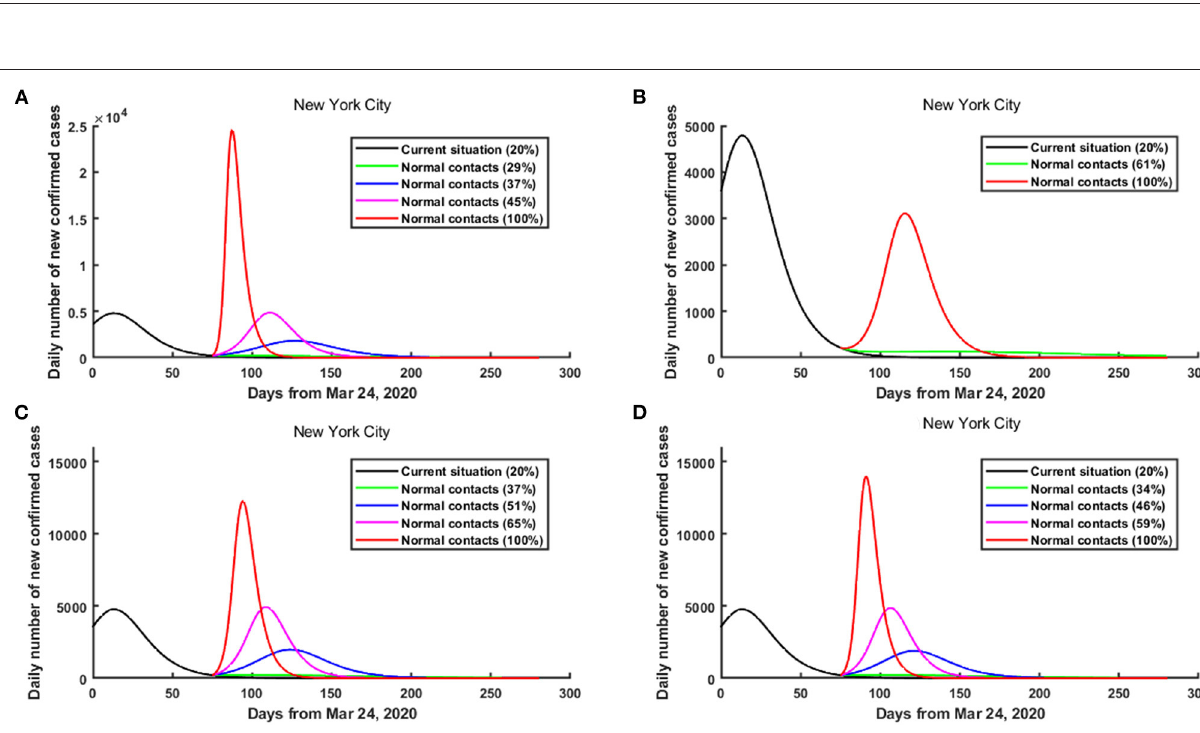
Frontiers in Medicine |